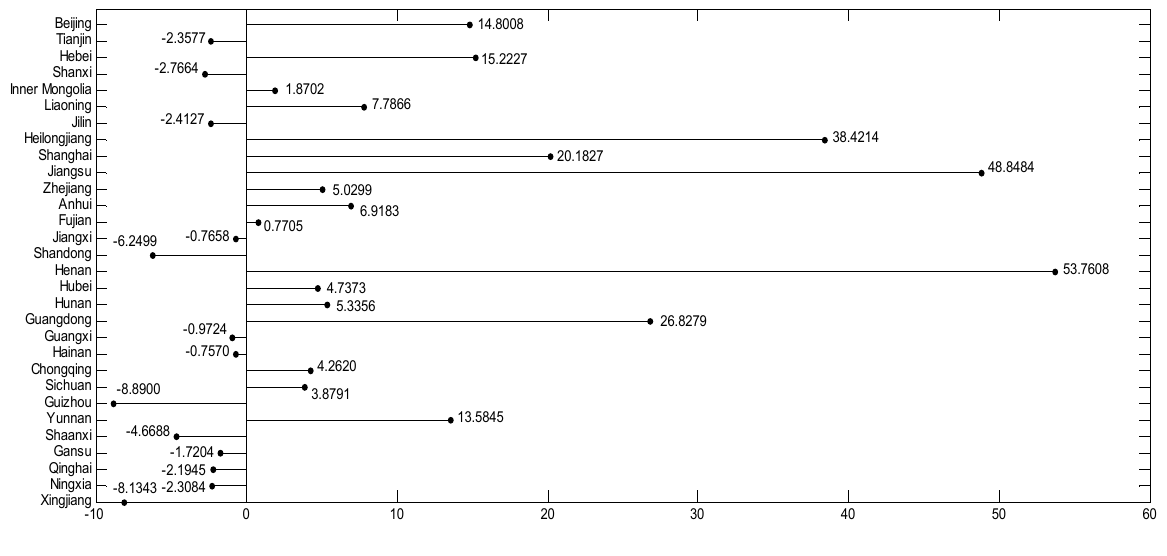
Figure 7. The contribution value of energy